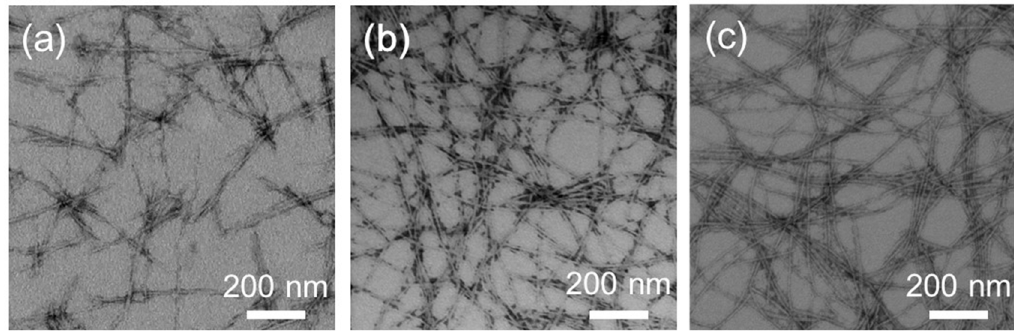
Figure 3. Negatively-stained TEM images of the nanofibers (NFs) obtained by incubation of the ( a ) EG 6 peptide, ( b ) EG 12 peptide, or ( c ) EG 24 peptide at a concentration of 300 µ M for 24 h in PBS at 60 ◦ C.